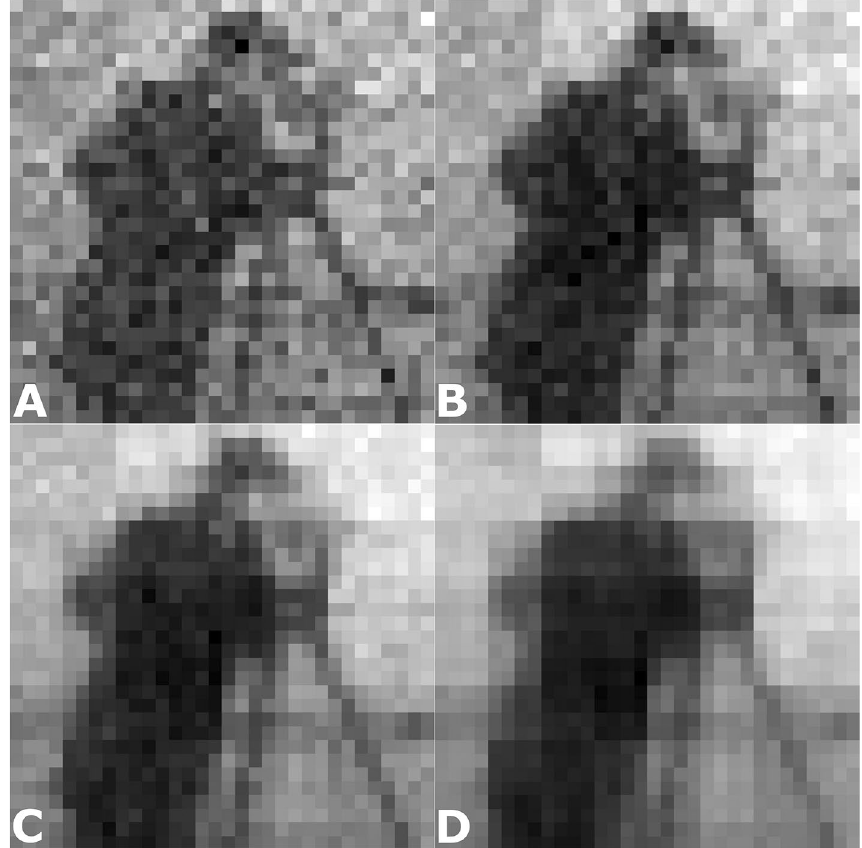
Figure 5. The images here are reconstructed using 2048 measurements in scenario shown in Fig. 4 ( C ). It illustrates a better reconstruction using a compressed sensing approach with 50% ( B ) and 25% ( C ) pattern sets in low SNR without any image processing. The “cameraman image” is adapted from the Massachusetts Institute of Technology, all rights